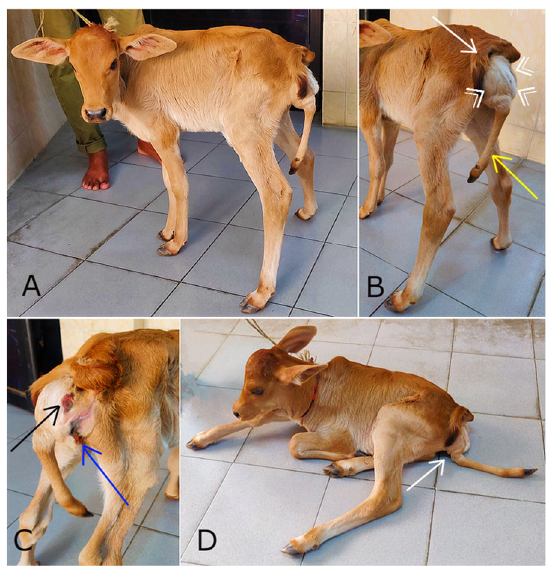
Fig. 1 The calf showing pygomelia in different positions. A An accessory hindlimb (small) with four normal limbs at standing position. B Hanging of the abnormal limb (yellow arrow) from the left lateroventral edge of the perineum (white arrow heads) below the tail (white arrow). C location of the limb in respect to the anus (black arrow) and vulva (blue arrow). D Sternal recumbency of the calf indicating the flexibility of the limb against the floor to its attachment (white arrow) within the perineal region near the caudal